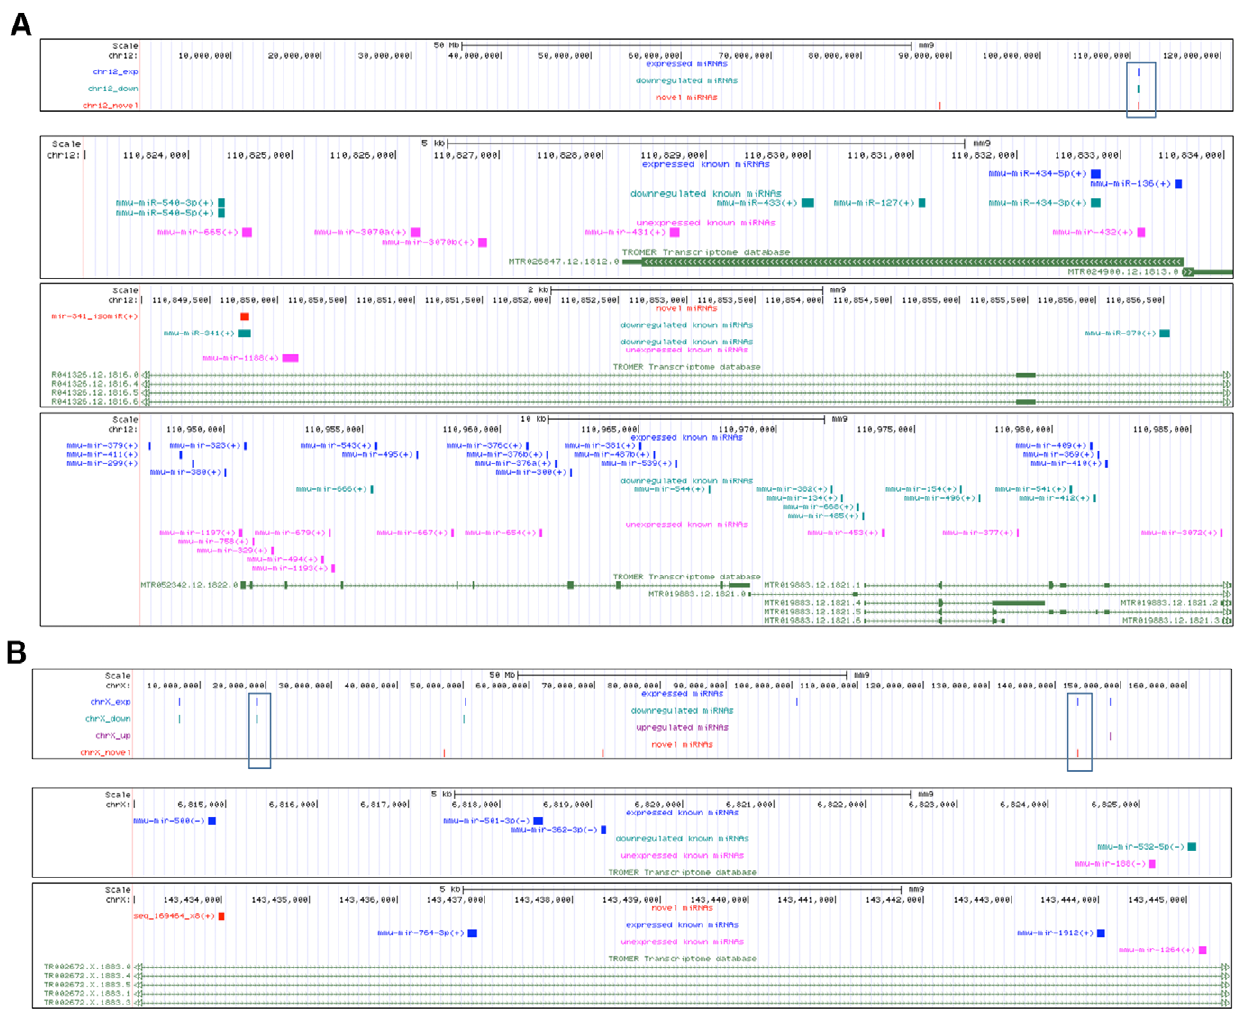
Figure 1. Novel miRNA candidates. ( a ) Novel miRNA candidates that change more than 2.0-fold in expression in old versus young mouse brains. MiRNA frequency was normalized by all reads that matched to the mouse genome (mm9) (Old/Young =1.472107). { : candidates validated by qRT- PCR. { : candidates with sequence overlap with known miRNAs (but have distinct mature miRNA sequences: isomiRs). A : Novel miRNA candidates that map to regions overlapping snoRNA and rRNA sequences (see main text). Blue font: miRNA novel to mouse. Black font: completely novel miRNA sequence, excluding seed sequence matches. Differentially expressed miRNAs with P-values , 0.05 (calculated using DEGseq [20]) indicated in bold. See also Table S4. ( b ) Secondary structures of putative precursor hairpins corresponding to nine novel miRNA candidates identified in this study. The predicted miRNA mature sequences are highlighted in red. Four of these novel miRNAs were found to be up-regulated (top) in aged mouse brain while five others were down-regulated (bottom). (See also Table S4). ( c ) Comparison of qRT-PCR data with deep sequencing data for the nine novel miRNA candidates shown in (b). Values shown are log2 ratios of old versus young brain expression levels. qPCR results were normalized to U6 snRNA expression levels. Inset: Correlation of expression changes as measured by deep sequencing versus qPCR (Pearson correlation coefficient =0.78). Plot for miR-5620 (isomiR) was taken out as the sequence was not reliably detected by qPCR. ( d ) Sequence alignment of novel miRNA candidates with known miRNAs of other species. *: conserved nucleotide. age: Ateles geoffroyi . bta: Bos taurus . dan: Drosophila ananassae . der: Drosophila erecta . dgr: Drosophila grimshawi . dme: Drosophila melanogaster . dmo: Drosophila mojavensis . dpe: Drosophila persimilis . dps: Drosophila pseudoobscura . dse: Drosophila sechellia . dsi: Drosophila simulans . dvi: Drosophila virilis . dwi: Drosophila willistoni . dya: Drosophila yakuba . gga: Gallus gallus . ggo: Gorilla gorilla . hsa: Homo sapiens . lla: Lagothrix lagotricha . mdo: Monodelphis domestica . mml: Macaca mulatta . mne: Macaca nemestrina . ppa: Pan paniscus . ppy: Pongo pygmaeus . ptr: Pan troglodytes . rno: Rattus norvegicus . sla: Saguinus labiatus . sme: Schmidtea mediterranea. xtr: Xenopus tropicalis .